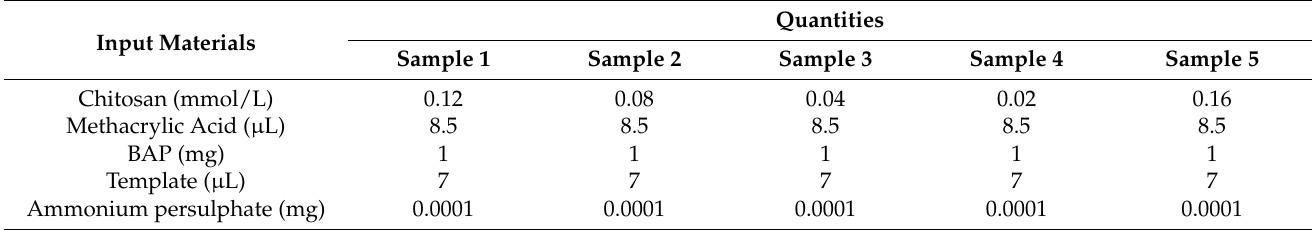
Table 1. Mole = 1 g of Chitosan in 10 mL 2% Acetic acid